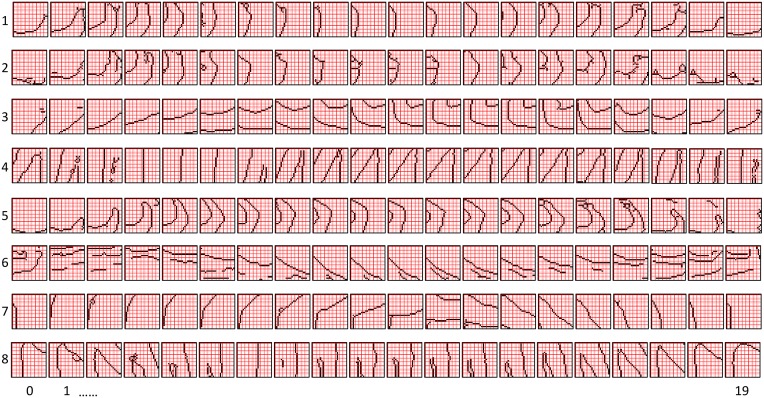
The frames of the eight snippets used in Study 2.